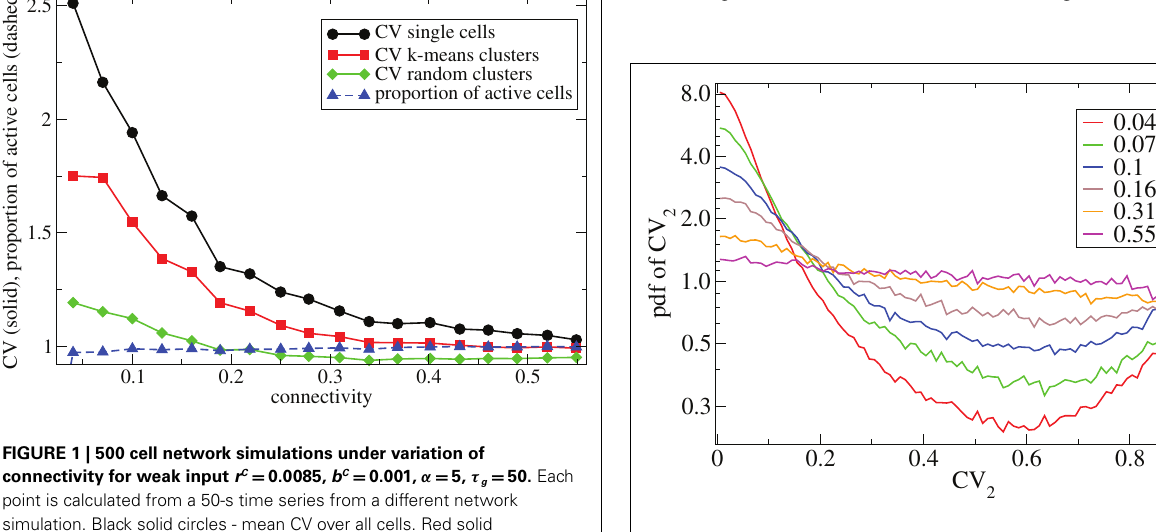
FIGURE 2 | CV 2 distributions for all cells combined for network simulations of different connectivities (see key) corresponding to Figure